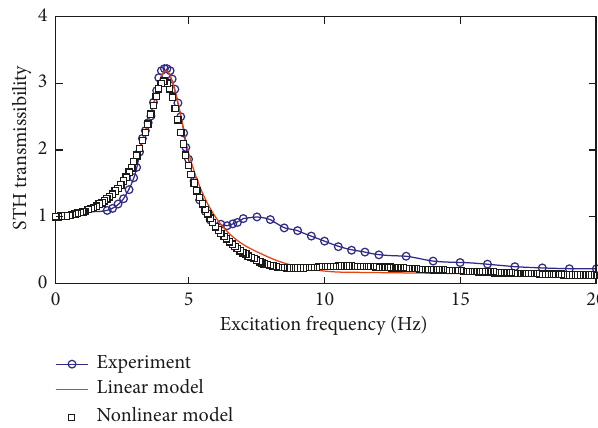
Figure 10: STH transmissibility of the linear and nonlinear pro- posed mathematical model and the experimental results [30] (nonlinear model: excitation amplitude of 3